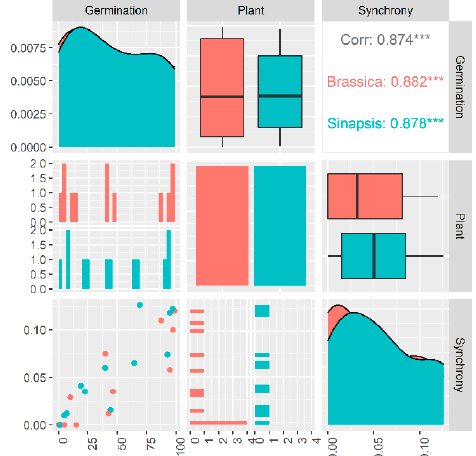
Figure 3. The relationship between germination and germination synchrony of two species belonging to Brassicaceae family. The boxplots, density plots and scatter plot between these traits are indicated. Spearman correlation was used to obtain the boxplots, density plots and scatter plot between these traits. Spearman’s rank correlation coefficient was estimated using Spearman correlation method. *** indicates significance level.